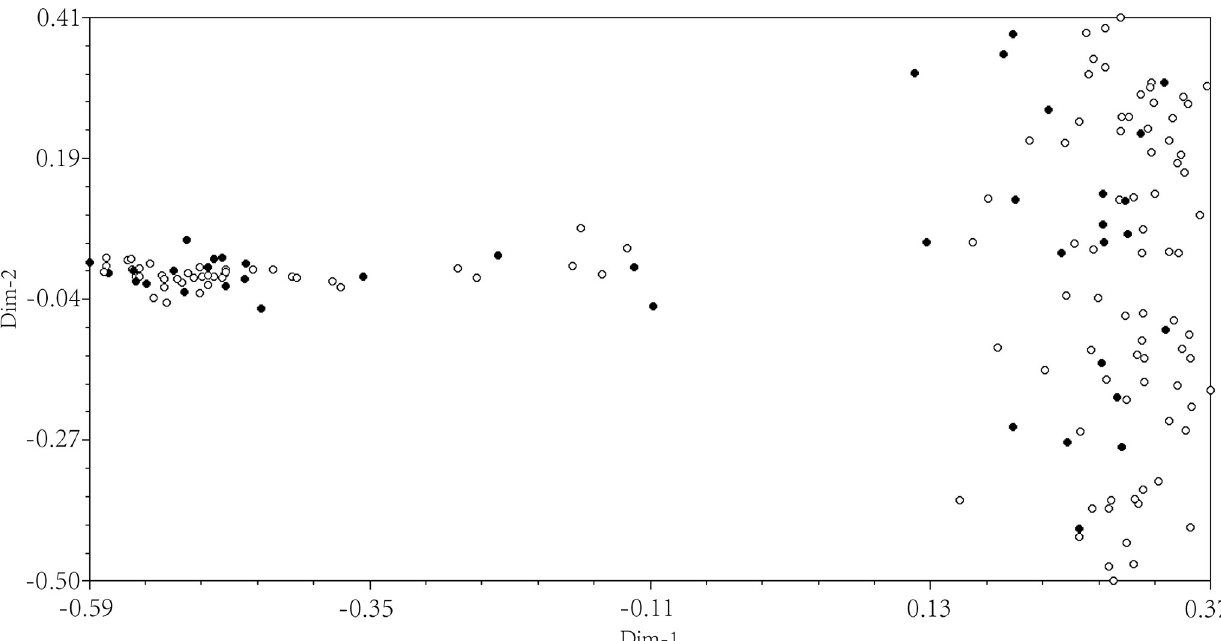
Fig 4. Principal coordinate plot of the core collection constructed using the preferred sampling strategy with 25% sample size and Nei & Li genetic distance and initial collection. The 118 accessions of the reserved collection were represented by open circles and the 40 accessions of the core collection were represented by black circles. All circles represented the 158 of the initial collection. Dim-1 and Dim-2 represented the first principal component score and the second principal component score of 158